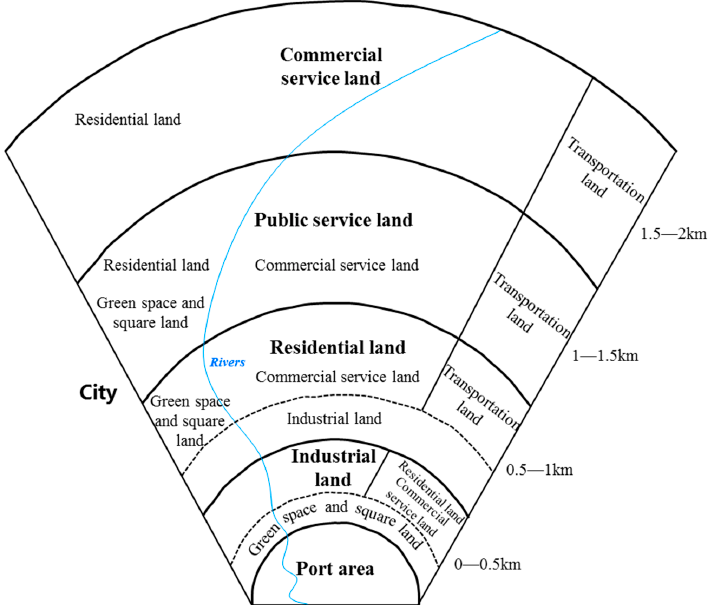
Figure 9. The urban regional structure model diagram of the estuarine port–city interface (source: drawn by author).